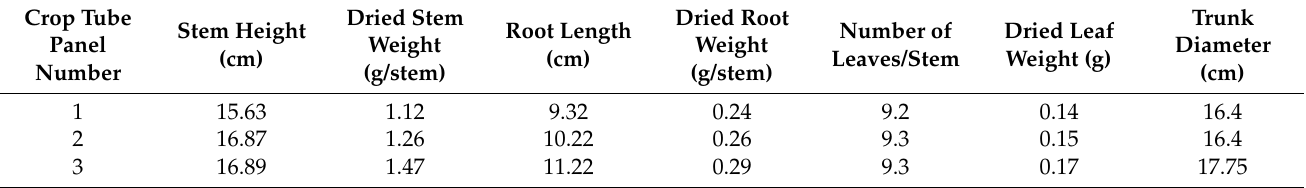
Table 4. The growth parameters of red oak in the 4th